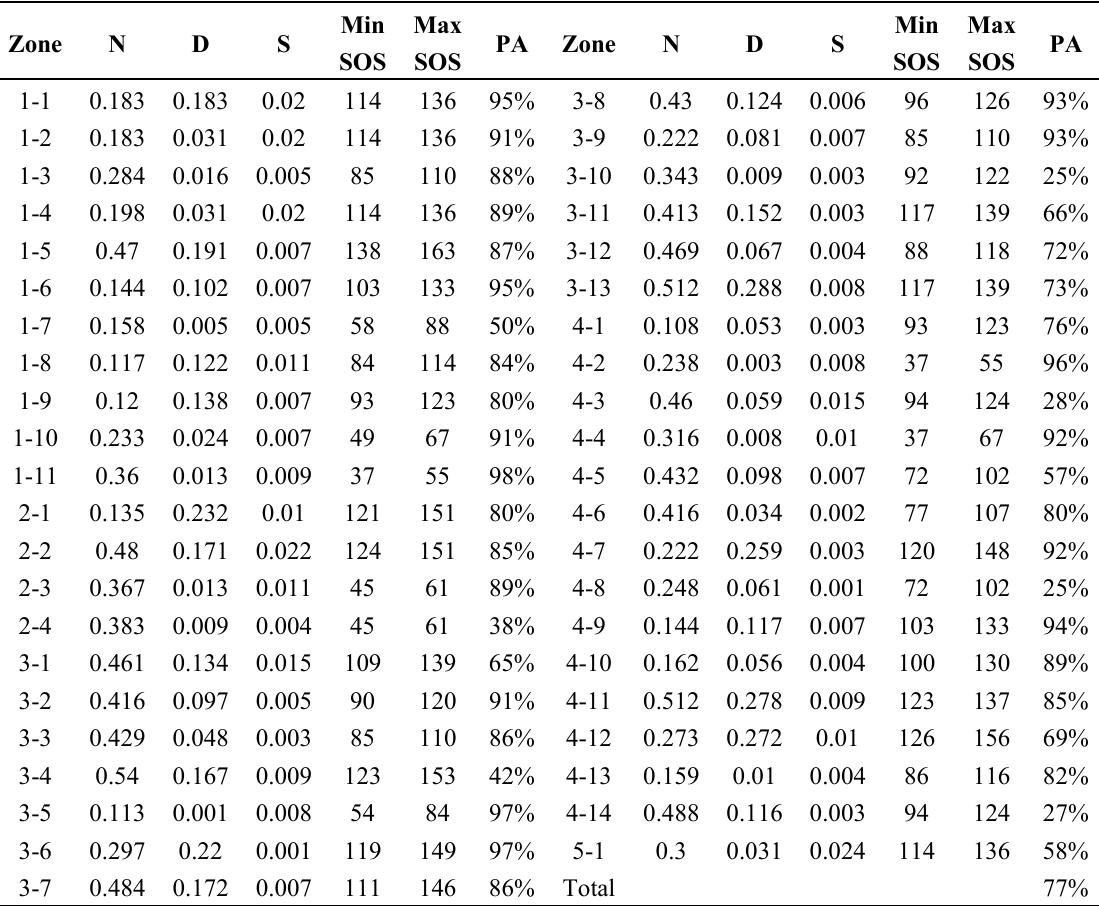
Table 1 . Groups of detection thresholds for SOS, MinSOS (in Day of Year (DOY)), MaxSOS (DOY), and percentage of accepted pixels (PA) for each zone. N = NDVI; D = Difference; S = Slope.